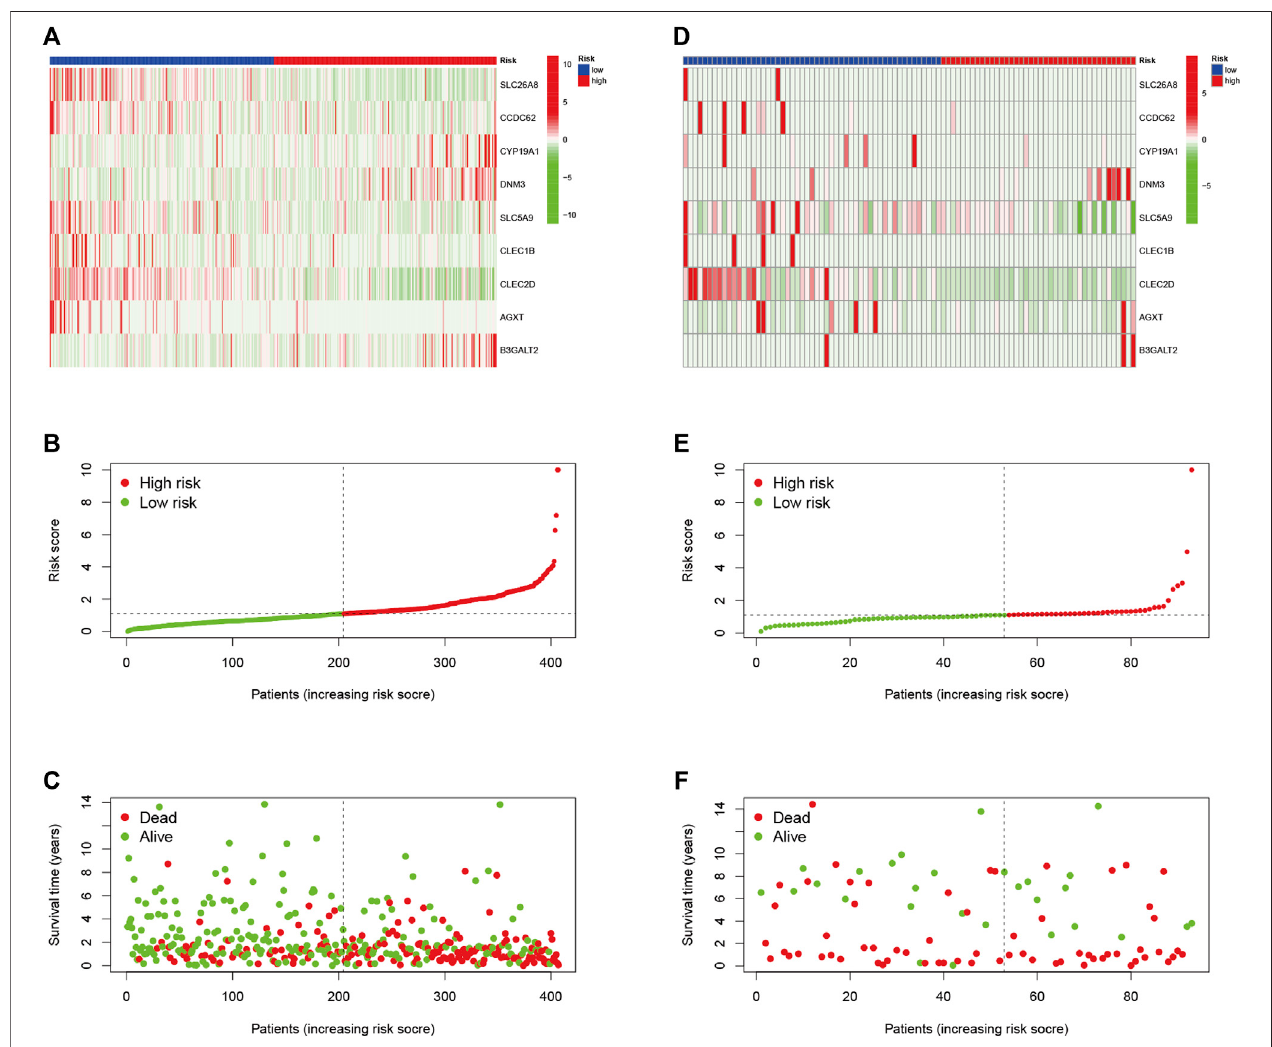
FIGURE 4 | (A) Con fi rmation of prognostic risk scores in the TCGA cohort (B) Polygenic model risk score distribution in the TCGA cohort (C) Survival status and durationofBLCApatientsintheTCGAcohort (D) Con fi rmationofprognosticriskscoresintheGEOcohort (E) Polygenic modelriskscoredistribution intheGEOcohort (F) Survival status and duration of BLCA patients in the GEO